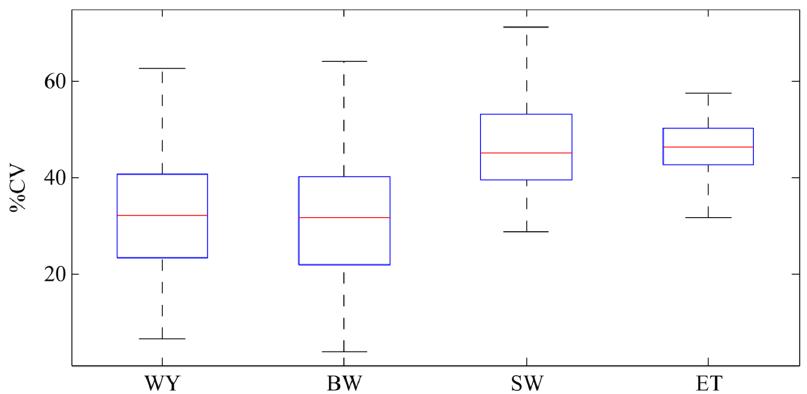
Figure 8. Comparison of the uncertainty in the water resource components stemming from the use of eight different input datasets. The boxplot shows the 25th and 75th percentiles of coefficient of variation (%CV) obtained from 480 simulations and the whiskers show the maximum and minimum %CV.